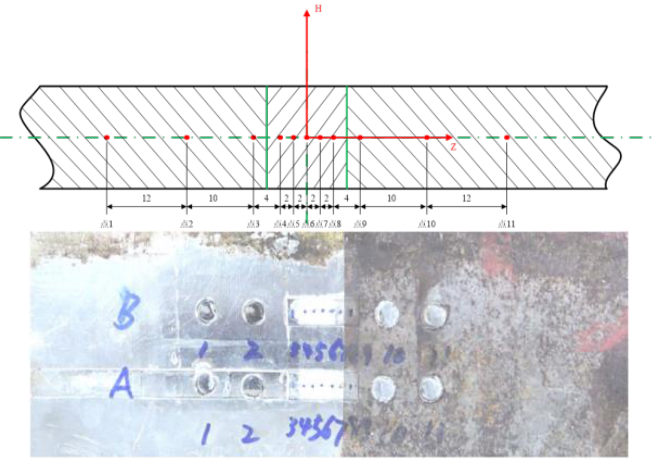
Figure 11. Location of residual stress measuring points on the outer wall of the test block.